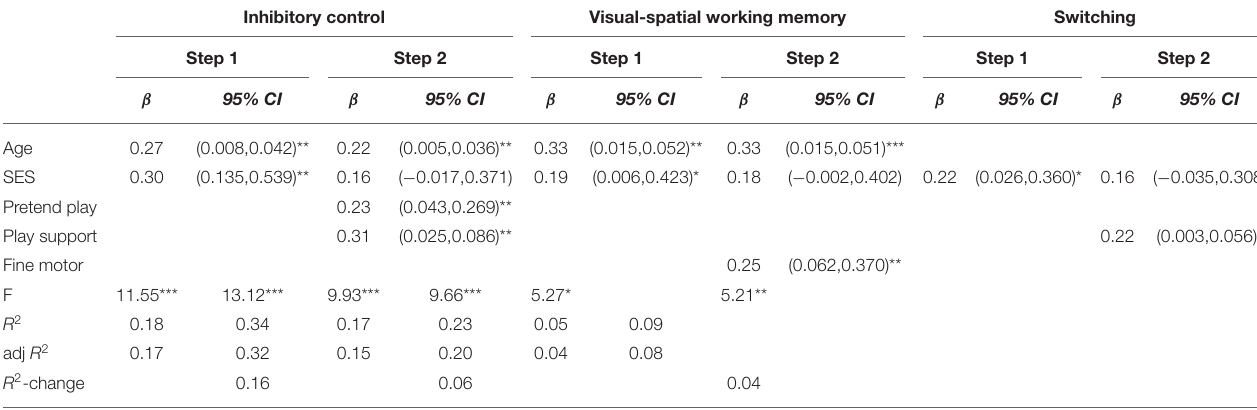
TABLE 8 | Summary of hierarchical multiple regression models predicting executive function skills in Hungarian sample. Inhibitory control Visual-spatial working memory